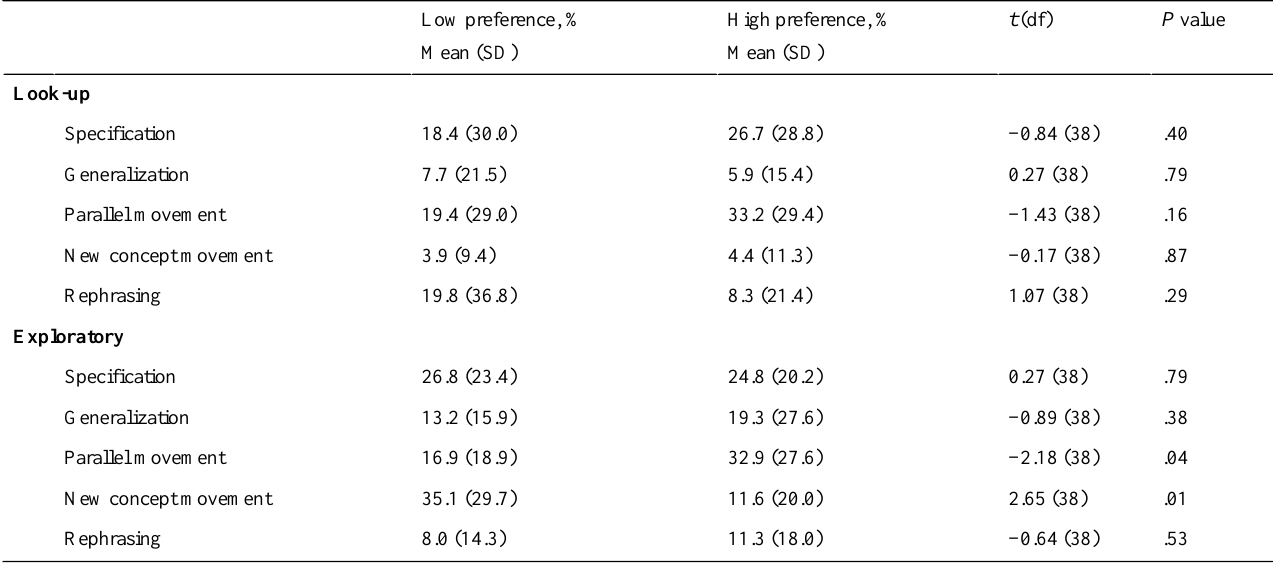
Table 5. The patterns of query reformulation.